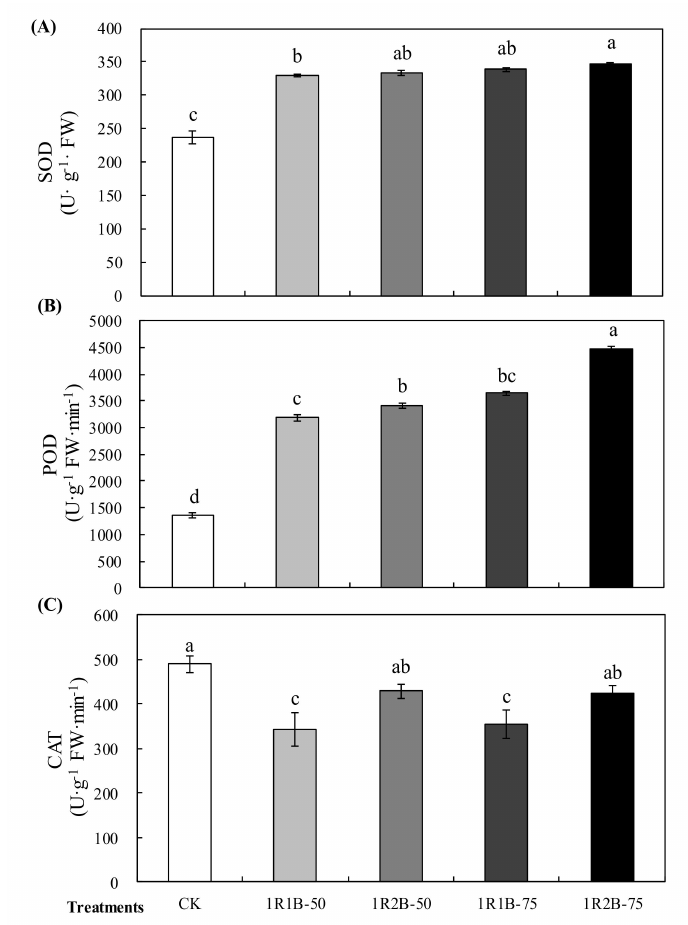
Figure 5. E ff ects of RB ratio and intensity of supplemental light on antioxidant enzyme activity of cucumber seedlings under extremely low irradiance. Sodium dismutase (SOD) ( A ), peroxidase (POD) ( B ) and catalase (CAT) ( C ). Di ff erent letters indicate statistically significant di ff erences among treatments (ANOVA, p ≤ 0.05).